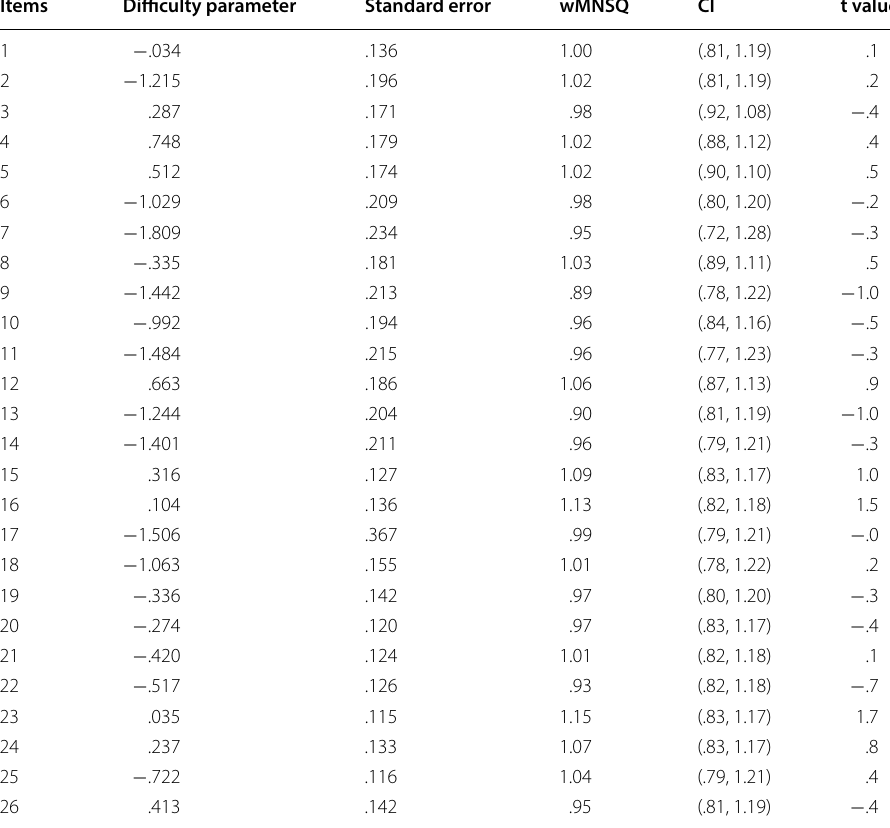
Table 7 Item fit statistics